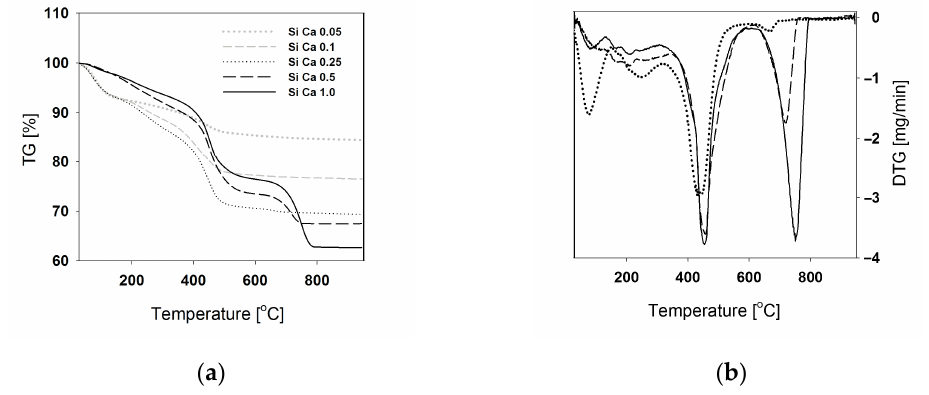
Figure 2. Thermogravimetric analysis of Ca/Si systems: ( a ) TG traces; ( b ) DTG